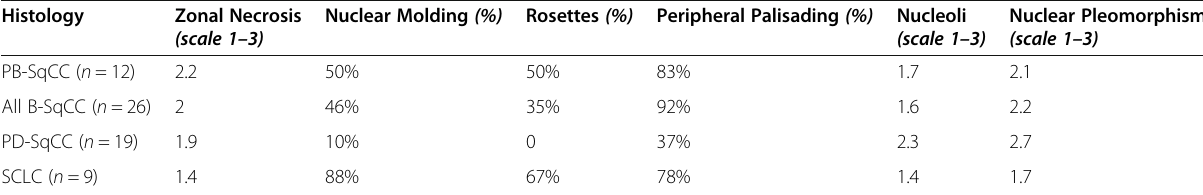
Table 1 Histological characteristics by tumor type